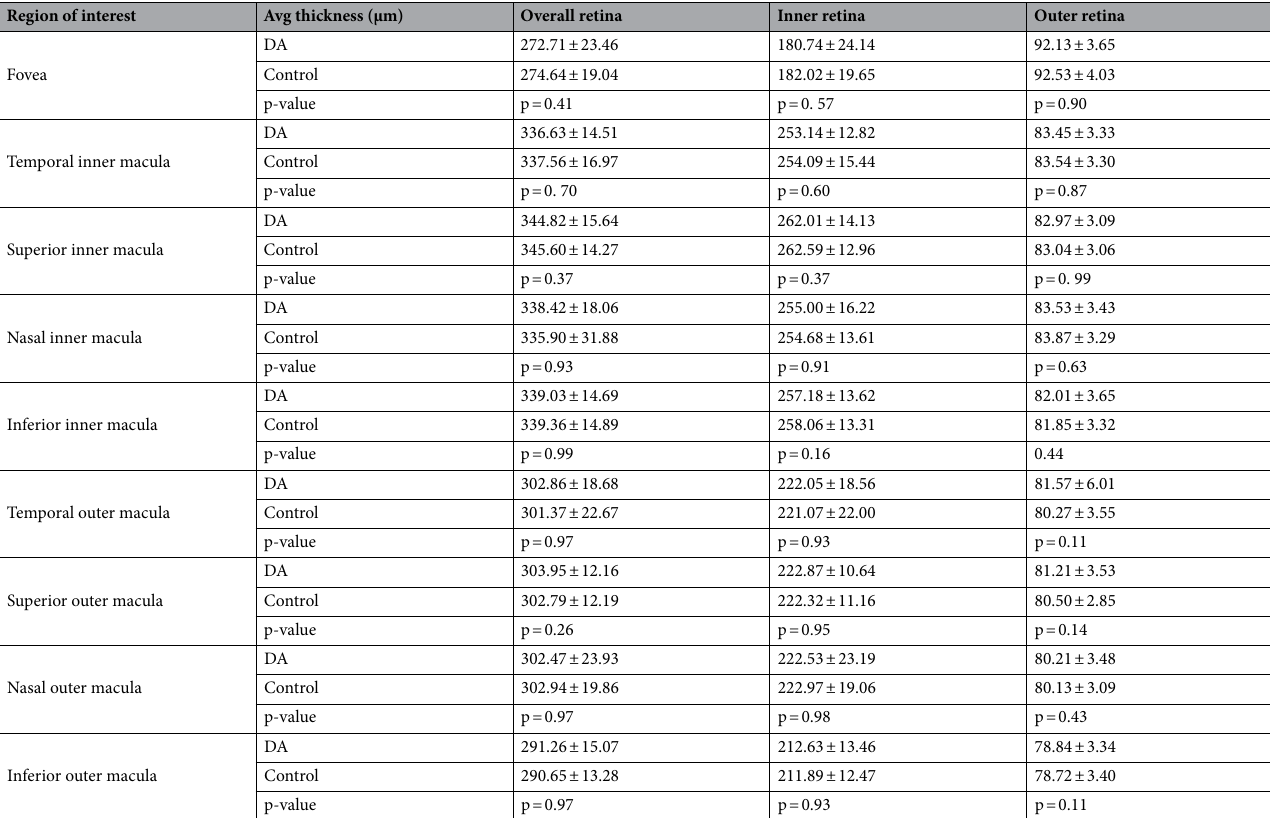
Table 2. Average thickness measurements and p-values for all 9 regions of interest (foveal and inner and outer perifoveal regions) between control and dark adaptation (DA)